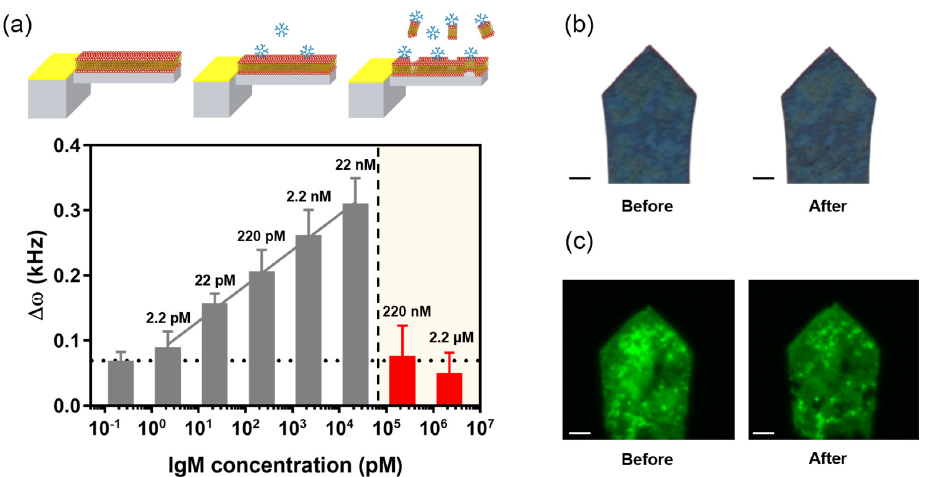
Figure 5. Selectivity of the EMMC. ( a ) Δ ω and ( b ) normalized Δ ω of the EMMC with interfering proteins. The selectivity test of EMMC with nonspecific IgM (Anti-A) and other interfering proteins (i.e., γ -Globulin and human serum albumin (HSA)). The IgM (Anti-B) and IgM (Anti-A) level was 22 nM, and the concentrations of all other interfering proteins were the same (0.1 mg/mL).